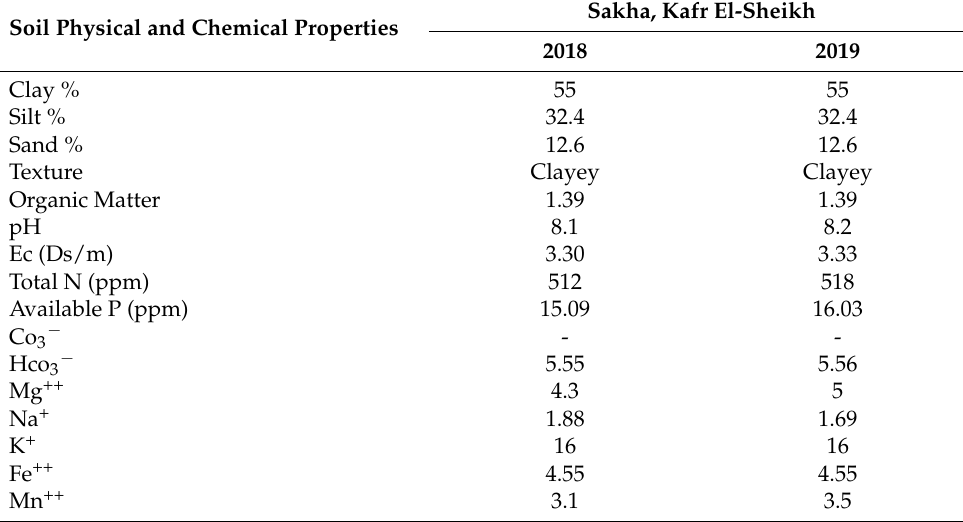
Table 1. Physical and chemical properties of soil at Sakha Research Station in 2018 and 2019 years (the soil was collected before starting the field preparation in each